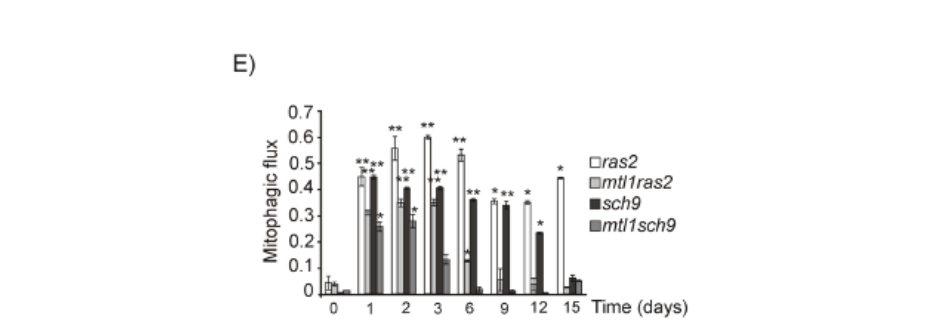
Figure 8. Mtl1 is needed for specific mitochondrial degradation during stationary phase. ( A ) wt and mtl1 cultures transformed with the plasmid Idp1–GFP were grown in SGly media plus amino acids at 30 ◦ C. Samples were taken at the indicated times to determine mitophagic flux. Mitophagic flux was calculated as the ratio between free GFP and total Idp1–GFP detected in the Western blot. ( B ) atg32 and atg11 cultures transformed with Idp1–GFP were grown in SGly medium plus amino acids at 30 ◦ C. Samples were collected at the indicated times to determine mitophagic flux as in ( A ). ( C ) wt, mtl1, atg1, atg7, atg11, atg32 and atg33 strains bearing the plasmid Idp1–GFP were grown in SD media at 30 ◦ C for 15 days in continuous shacking. Mitophagic flux was determined as in A. ( D ) Chronological life span curves for wt, mtl1, atg1, atg7, atg11, atg32 and atg33 strains cultured in SD media plus amino acids at 30 ◦ C. Samples were taken at the indicated times to determine CLS, as described in the Materials and Methods. Numerical data regarding maximum life span (the day when cultures reach 10% survival) and average life span (the day at which 50% survival was recorded) for each strain is depicted. ( E ) ras2, mtl1ras2, sch9 and mtl1sch9 mutants, transformed with Idp1–GFP were treated as in ( C ) and mitophagic flux was determined as in ( A ). Error bars in the histograms represent the standard deviation (SD) calculated from three independent experiments. Significance of the data was determinate by p -values from a Student’s unpaired t -test denoted as follows: * = 0.05 > p > 0.01; ** = 0.01 > p >